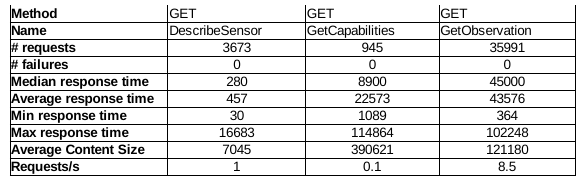
Table 4. VM-0 test results with 500 users.